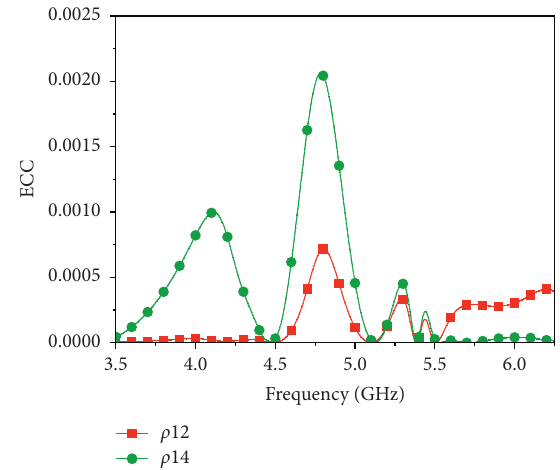
Figure 14: Computed ECC of the proposed MIMO antenna using S-parameters.